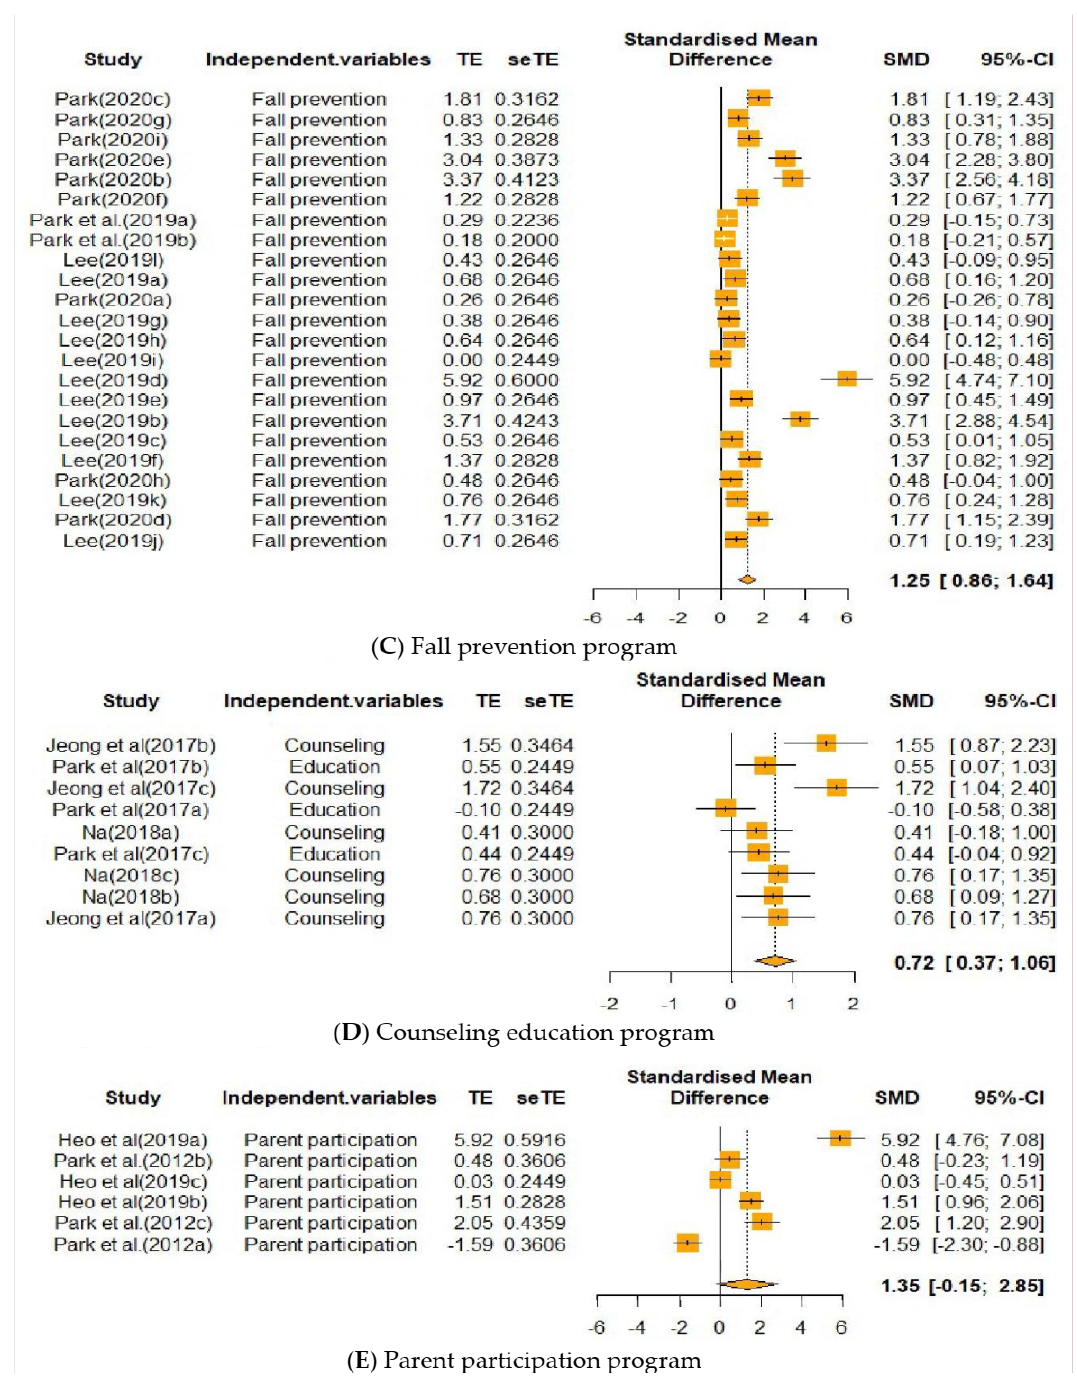
Figure 4. Forest plot of the effect of independent variables: ( A ) Health promotion program, ( B ) Goal setting and health contract program, ( C ) Fall prevention program, ( D ) Counseling education program, ( E ) Parent participation